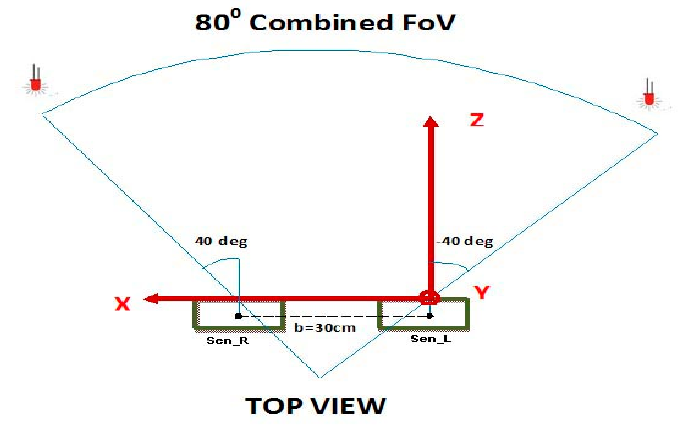
Figure 1. System overview.